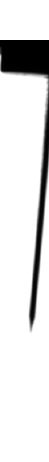
Figure 13. The large rotational images. ( a ) Left rotated; ( b ) right rotated.